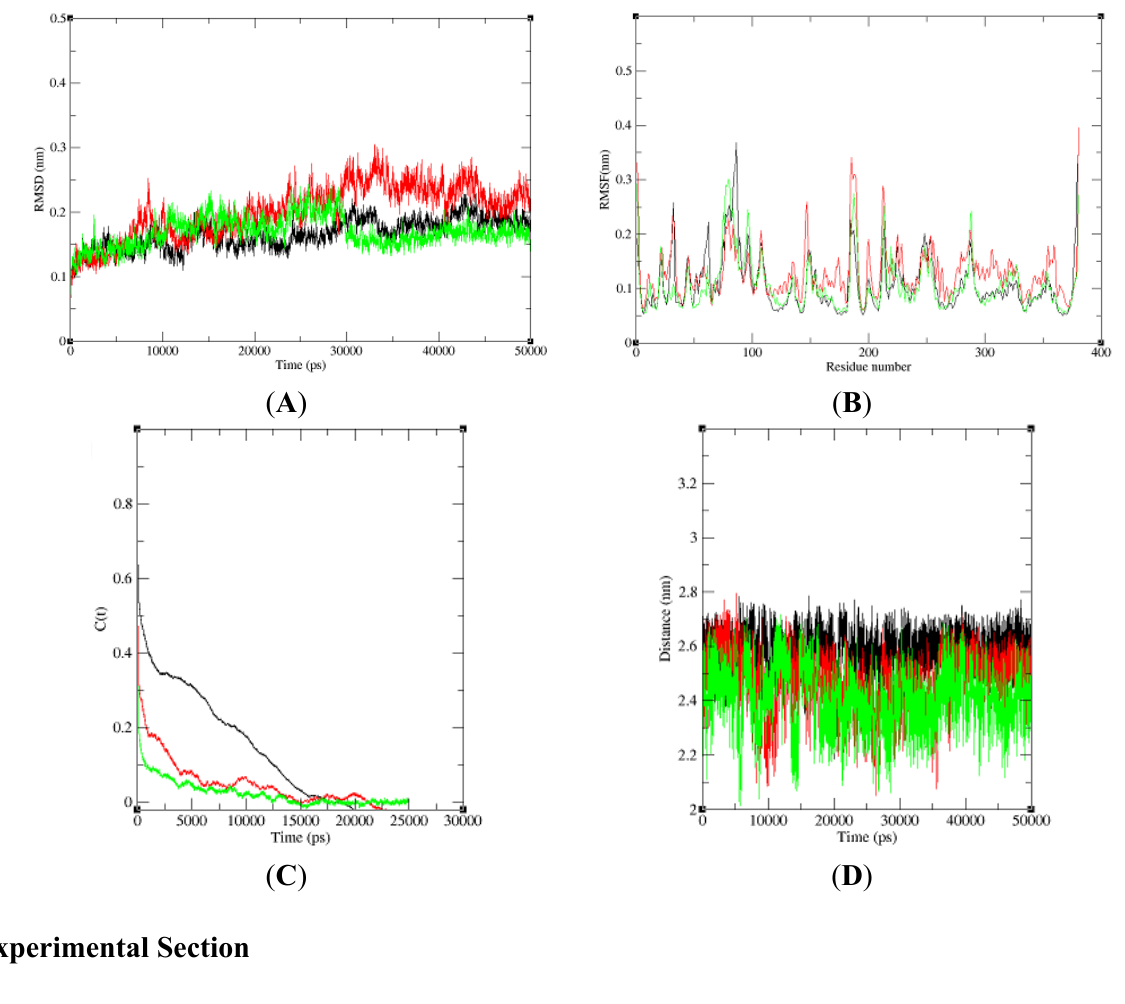
Figure 8. Dynamic changes of the NBD, K71L and T204V-E1A32 kDa motif complex structures. ( A ) Root mean square deviations (RMSD) of NBD (black), K71L (yellow) and T204V (brown); ( B ) Backbone atomic fluctuations (RMSF) of NBD (black), K71L (red) and T204V (green); ( C ) Hydrogen bond autocorrelation of NBD (black), K71L (red) and T204V (green); ( D ) Salt bridge of NBD (black), K71L (red) and T204V